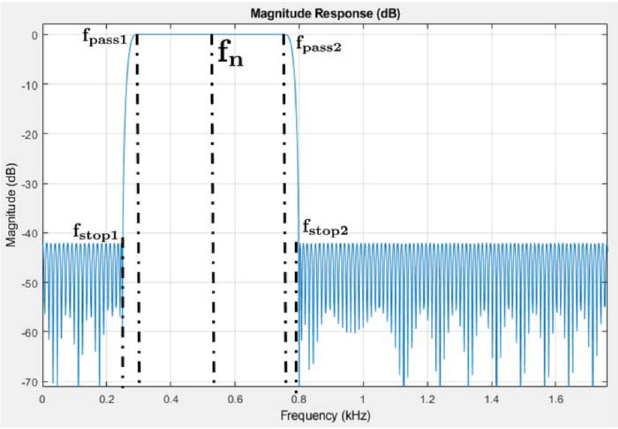
Figure 7. Adopted Parks–McClellan FIR passband filter.